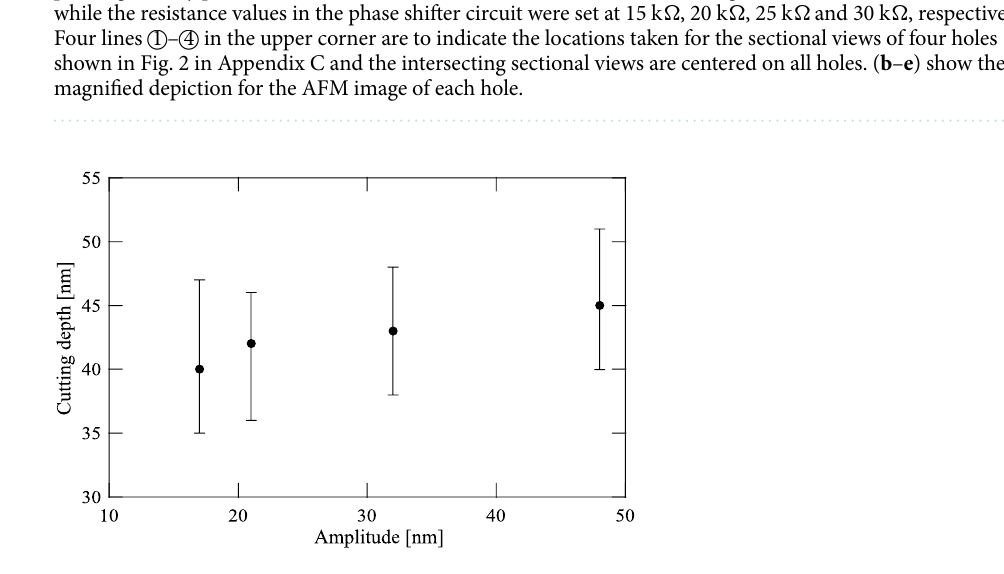
Figure 14. Depths for the holes I, II, III and IV are the average value for all sectional views for each hole. Four holes were cut under application of the 400 µ N pressing load when the four resistance values in the phase shifter were set as 15 k (cid:31) , 20 k (cid:31) , 25 k (cid:31) and 30 k (cid:31) , respectively. The corresponding amplitudes were 17 nm, 21 nm, 32 nm and 48 nm,